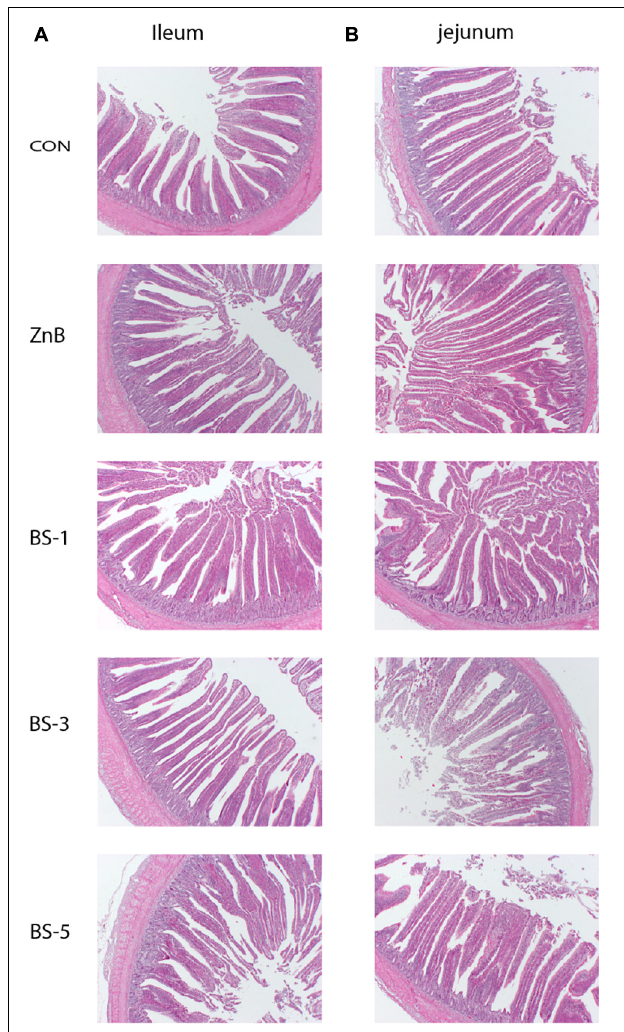
FIGURE 1 | Electron micrograph images of the ileum (A) and jejunum (B) tissues from broiler treatments. CON, chicks were fed a corn- and soybean-based diet; ZnB, chicks were fed basal diet containing 500 mg ZnB/kg; BS-1, chicks were fed basal diet containing 1 × 10 8 CFU/g feed of BS- ATCC19659; BS-3, chicks were fed basal diet containing 3 × 10 8 CFU/g feed of BS- ATCC19659; BS-5, chicks were fed basal diet containing 5 × 10 8 CFU/g feed of BS-